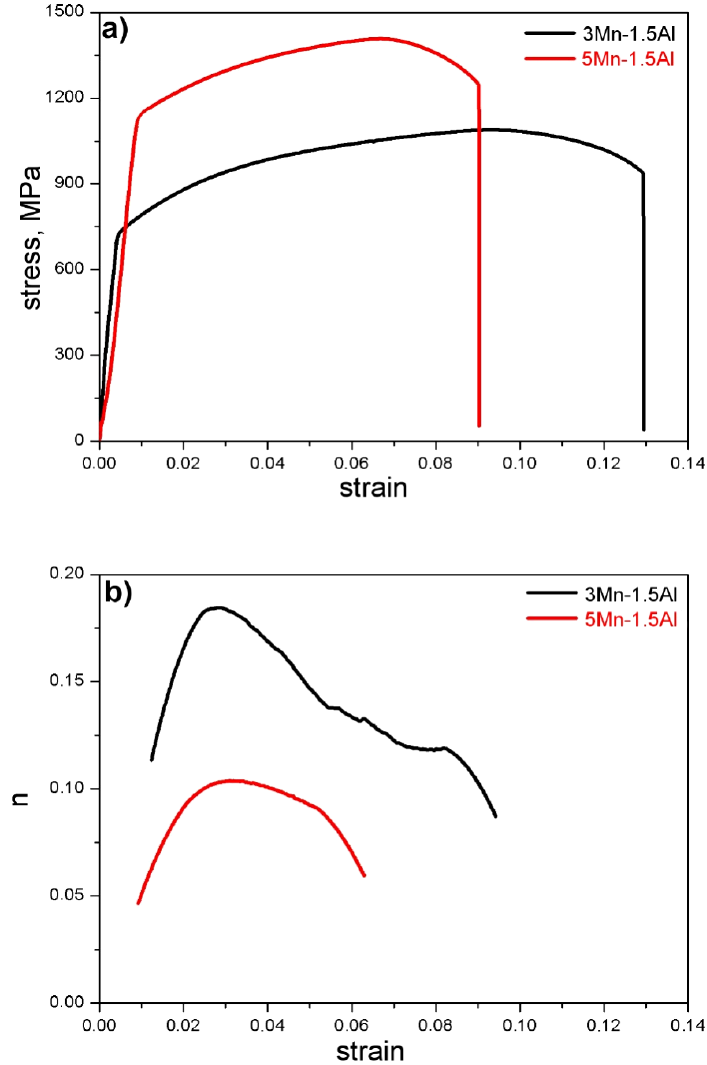
Figure 7. True stress–true strain curves of investigated steels ( a ) work hardening exponent as a function of true strain ( b ).